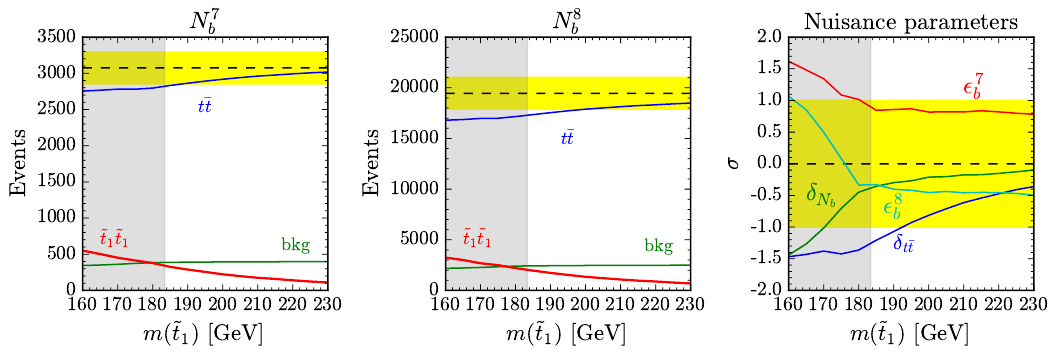
Figure 12 . The left and middle panels show the best (cid:12)t number of expected events for a signal strength (cid:22) = 1 in the single b -tagged signal region for m (~ (cid:31) 0 ) = 1 GeV at p s = 7 ; 8 TeV respectively. 1 The blue, green, and red lines each show the contributions from t (cid:22) t production, other Standard Model backgrounds, and stop pair production, respectively. The dashed line shows the Standard Model expectation for the number from t (cid:22) t events and the yellow shaded region illustrates the one standard deviation uncertainty. The gray shaded regions are excluded. The right panel shows the number of standard deviations the nuisance parameters shift from their central values to maximize the